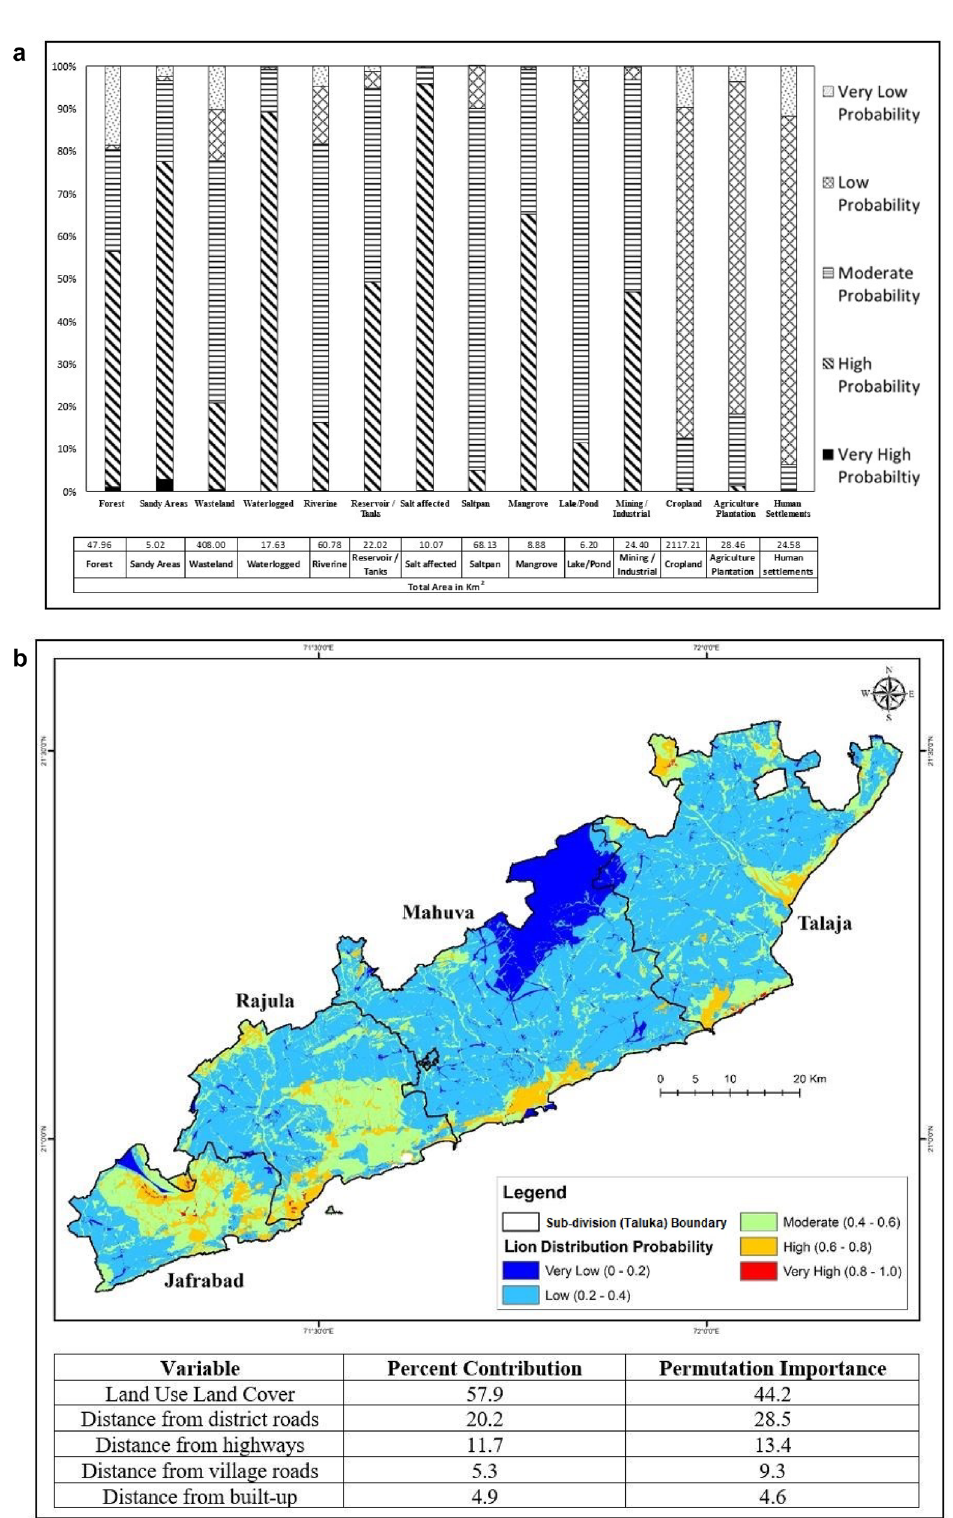
Figure 4. ( a ) The proportion (%) of very low to high probability areas under each LULC category in the eastern coastal lion habitat. The table indicates the total area (km 2 ) under each category in the eastern coastal lion habitat of the study area, covering 1413 km 2 . ( b ) Lion distribution map of lions ranging in the eastern coastal habitat based on MaxEnt models. Red colours indicate a higher “probability of occurrence” (suitability), while blue colours indicate lower probabilities. Using the MaxEnt logistic output, the percent contribution and permutation Importance are shown in the table. LULC was found to contribute the majority